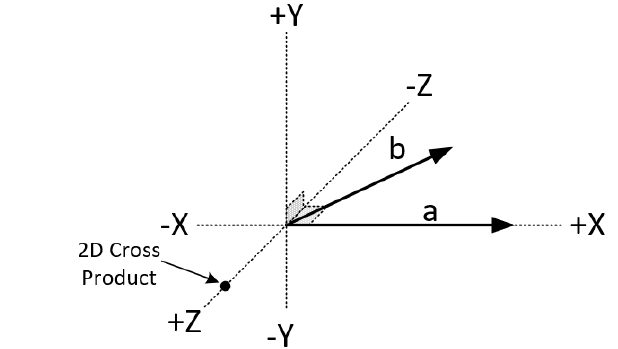
Figure 33. From the sign of the 2D cross product we can determine, if vector b is to the left, to the right or on vector a .